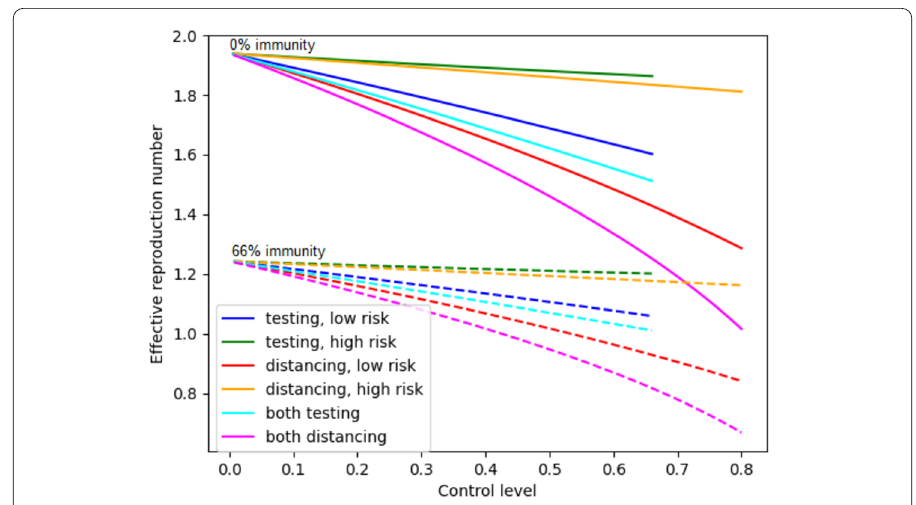
Figure 2 Dependence of R e on control level for six control strategies at 0% and 66.6%